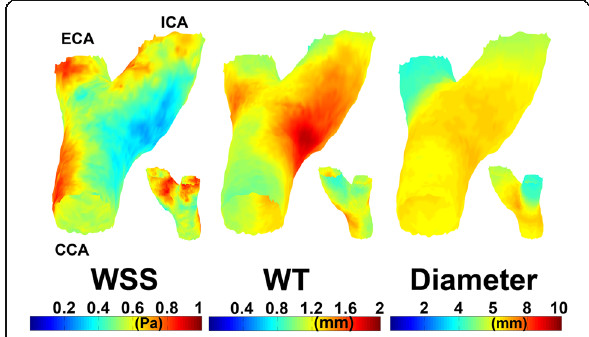
Fig. 3 The mean map of 1000 bootstraps of the left carotid bifurcation for wall shear stress ( WSS ), wall thickness ( WT ) and vessel diameter. Insets show the 180° reversed